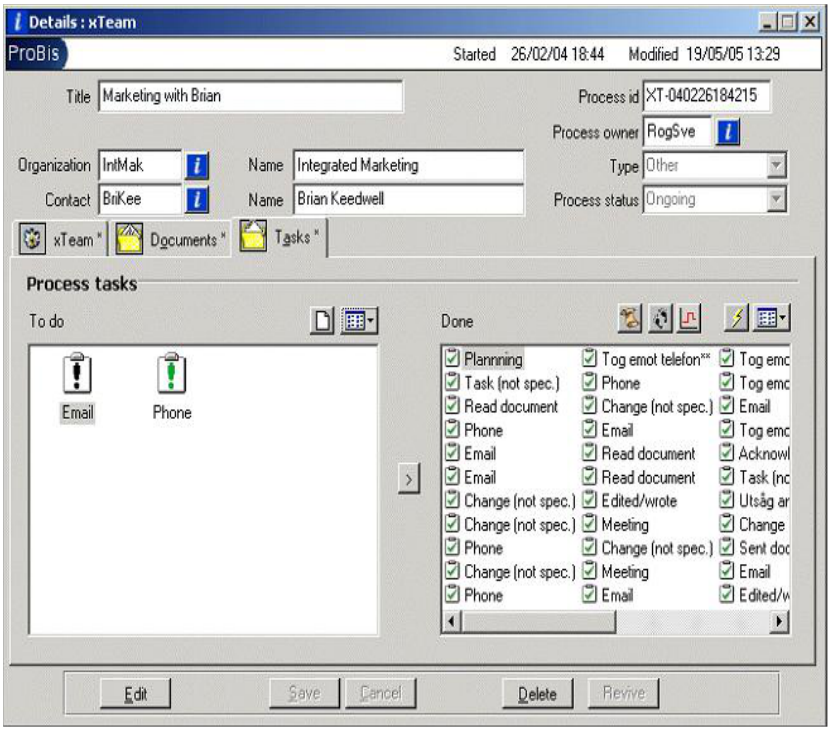
Figure 5. A topic-based structure of a shared space employed in ProBis